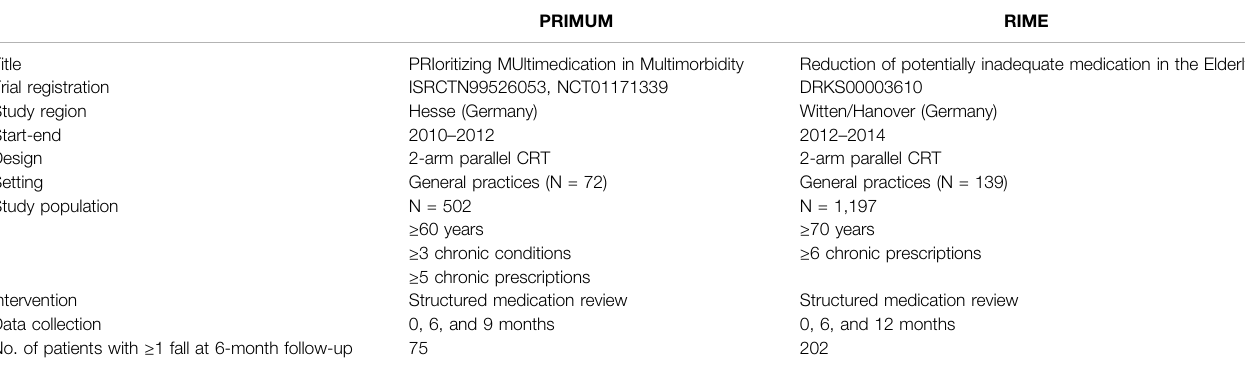
TABLE 1 | Main characteristics of the included